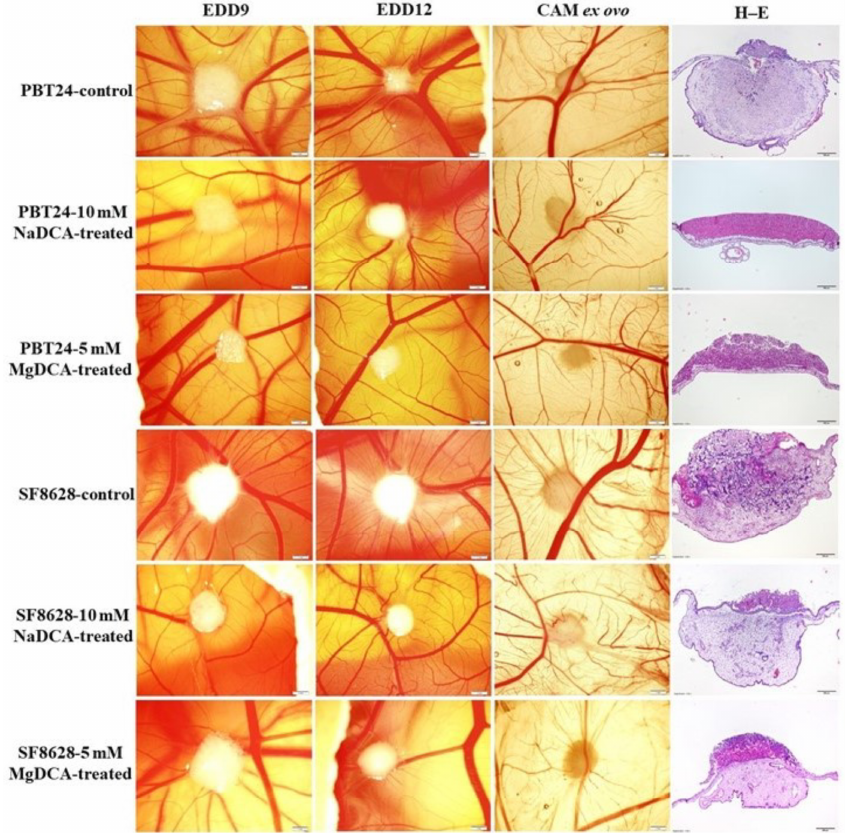
Figure 1. Stereomicroscopic and histologic images of PBT24 and SF8628 tumors in vivo on the CAM, the tumor ex ovo, and the H–E stained tumors histologically. EDD9, EDD12, and CAM ex ovo scale bar is 1 mm; H–E preparations’ scale bar is 200 µm.